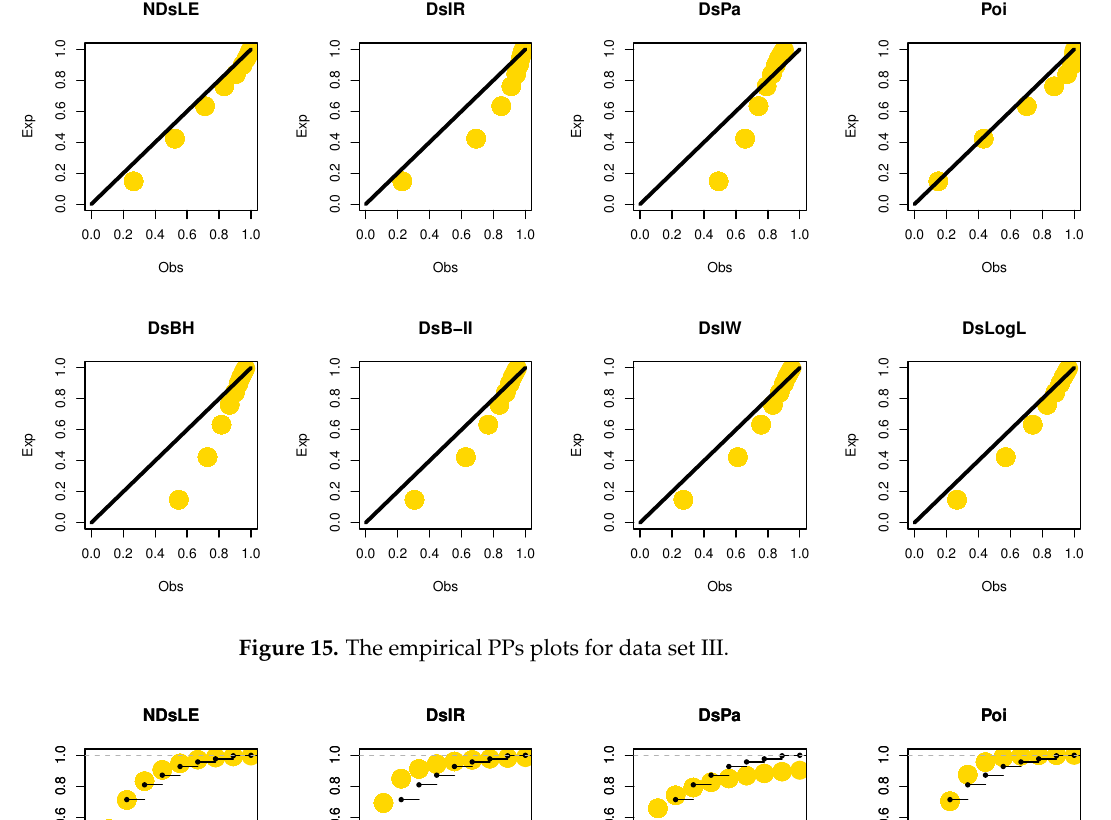
Figure 15. The empirical PPs plots for data set III.